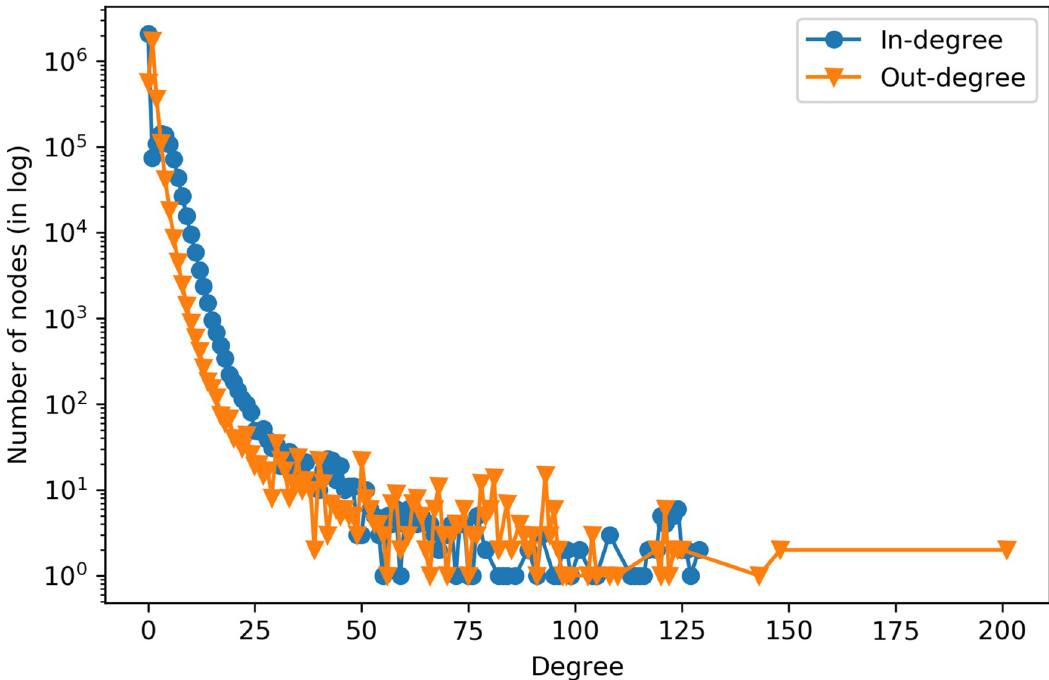
Fig 4. Degree distribution of citations (best viewed in color).